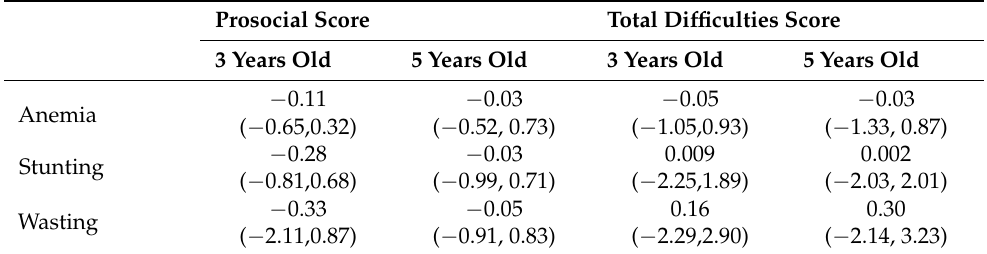
Table 5. Cross-sectional associations among anemia, stunting, wasting, and child socio-emotional outcomes. Values are coefficient (95%